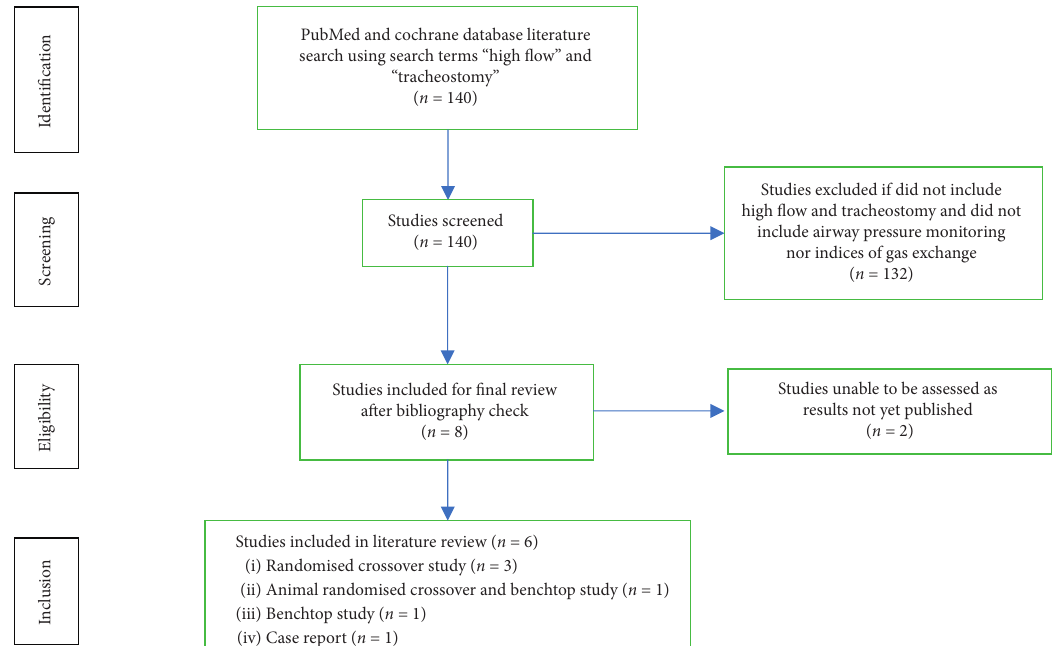
Figure 1: PRISMA diagram to outline selection of cases for literature